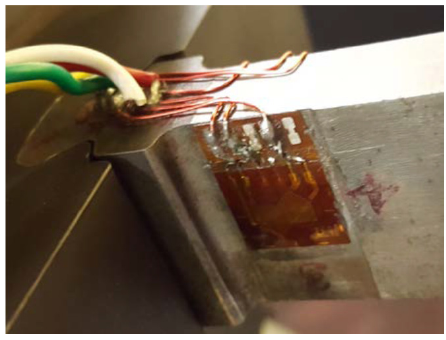
Figure 5. Strain gauge configuration for strain measurement system.